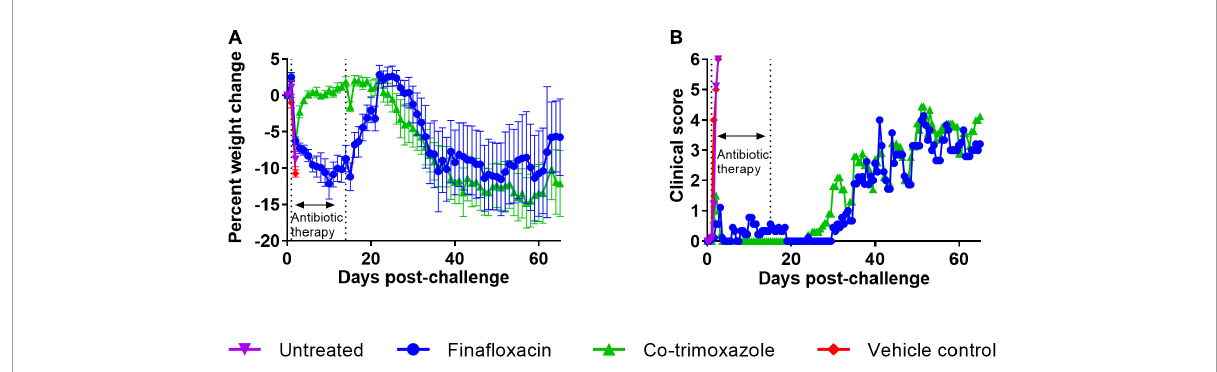
FIGURE3 The weight loss and clinical scores of mice challenged with B. mallei and treated with antibiotics. Mice were challenged with a mean retained dose of 1.52 × 10 4 CFU of B. mallei . Therapy was initiated at 24 h post-challenge with finafloxacin (37.5 mg/kg) every 8 h or co-trimoxazole (78 mg/kg) every 12 h by the oral route. Control animals received vehicle by the oral route. Treatment was continued for 14 days. The mean percentage weight loss when compared to the original bodyweight is shown for each treatment group (A) and the mean clinical score (B)